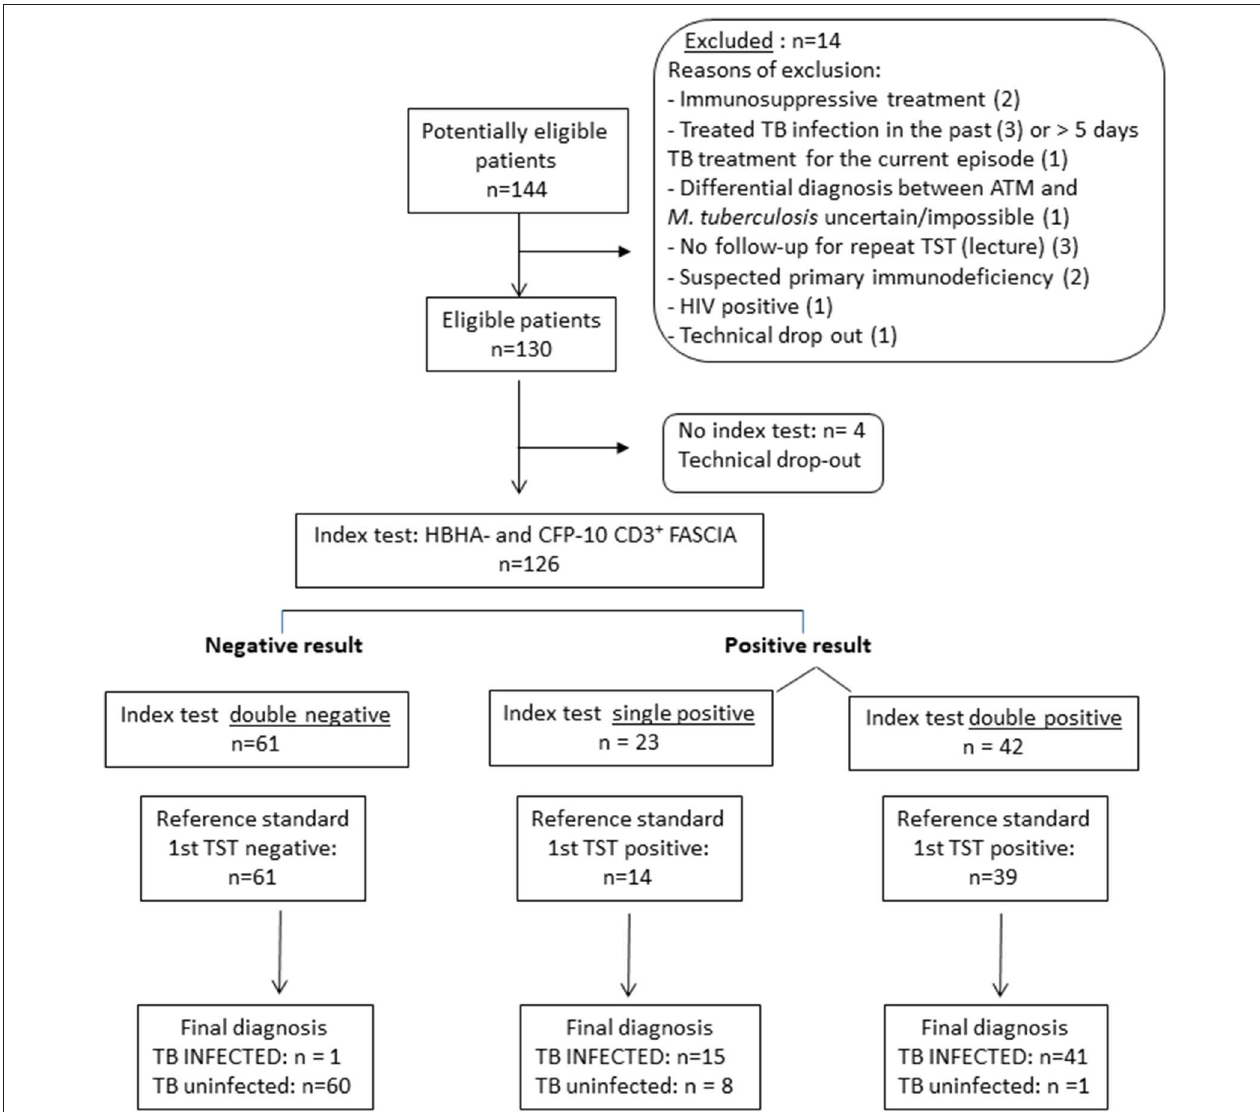
FIGURE 1 | STARD diagram reporting the flow of children for the evaluation of the combined HBHA- and CFP-10-induced CD3 + blasts lymphocytes for the identification of M. tuberculosis- infected children (LTBI/aTB). The aim of this index test was to correctly classify children exposed to an index case of aTB disease in two groups: non-infected children, and infected children comprising both children with LTBI and those with aTB disease. The reference standard test was the tuberculin skin test (TST) performed at the inclusion of the child in the study (first TST), the TST being the reference test recommended in Belgium and in most European countries at least for children younger than 5